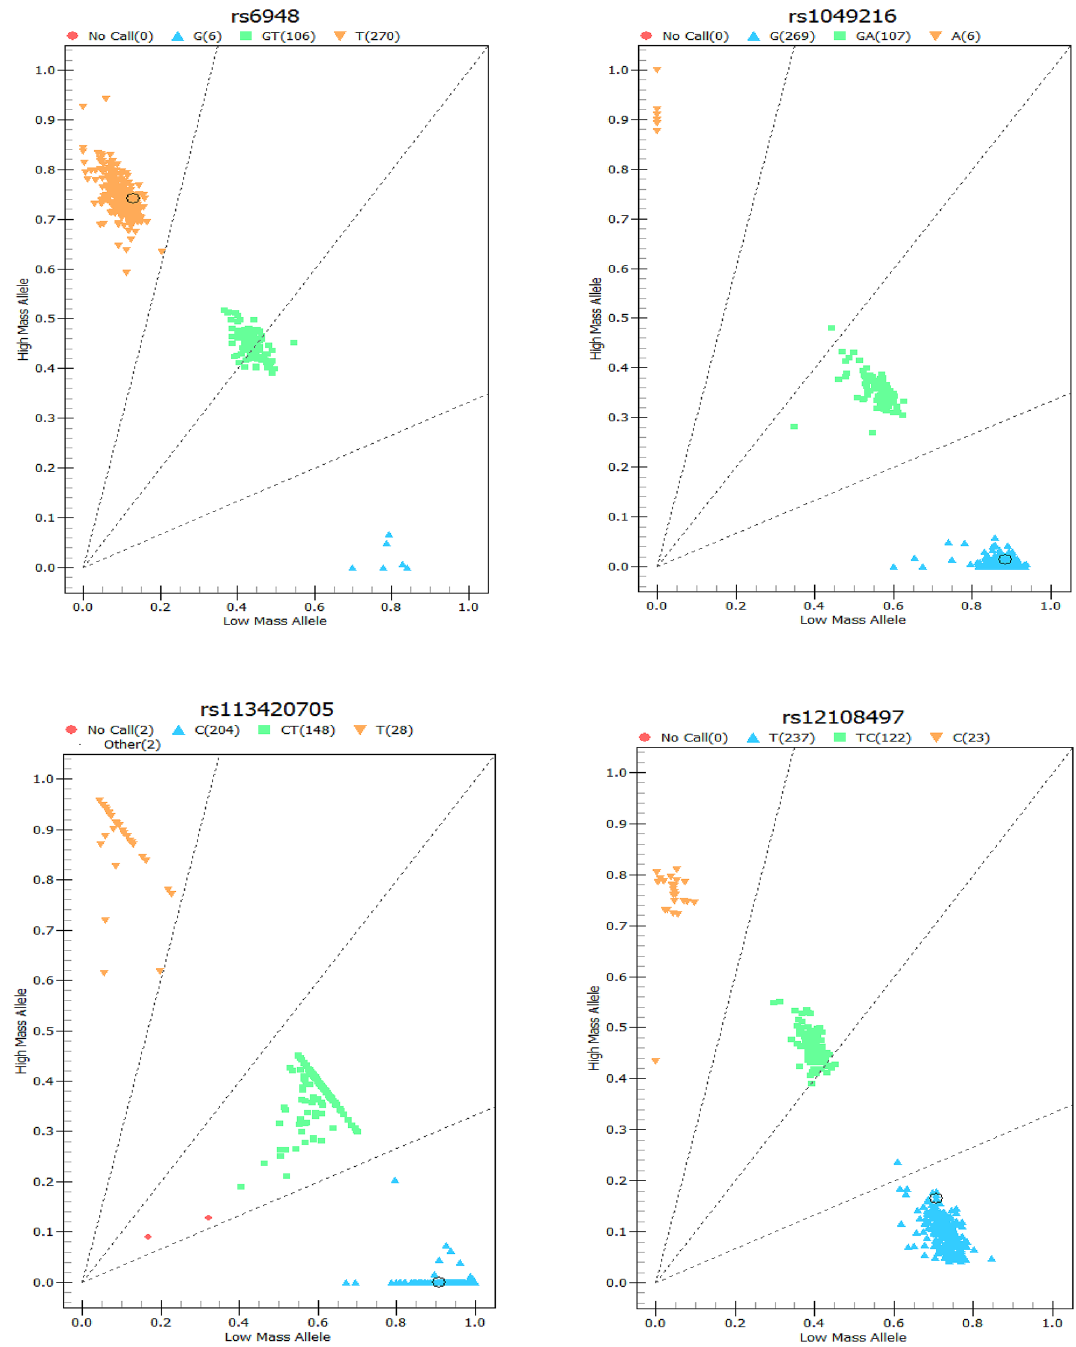
Figure 1. Gene coordinates for SNP